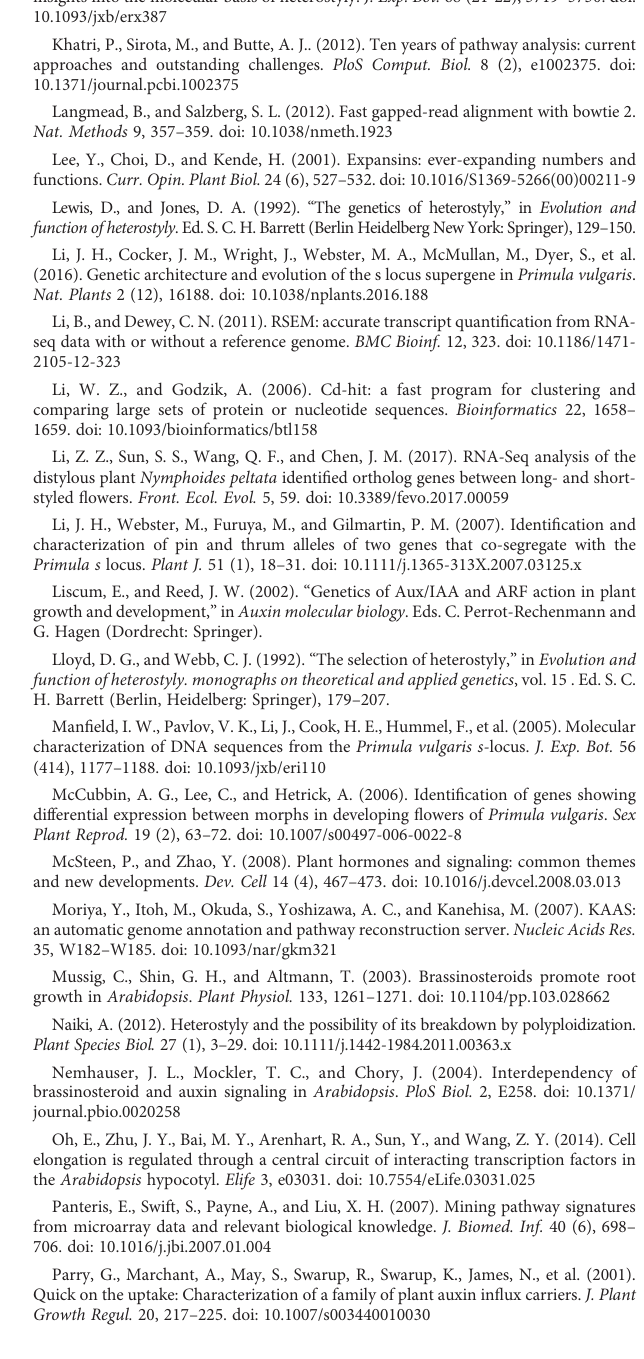
SUPPLEMENTARY FIGURE 1 A. Read length distribution of consensus isoforms; B. Distribution of the protein sequence lengths coded by complete ORFs. SUPPLEMENTARY FIGURE 2 The distribution of transcription factors in different gene families. SUPPLEMENTARY FIGURE 3 Number of differentially expressed genes between L- and S-morph styles (blue) and fl oral tubes (orange) in three developmental stages.